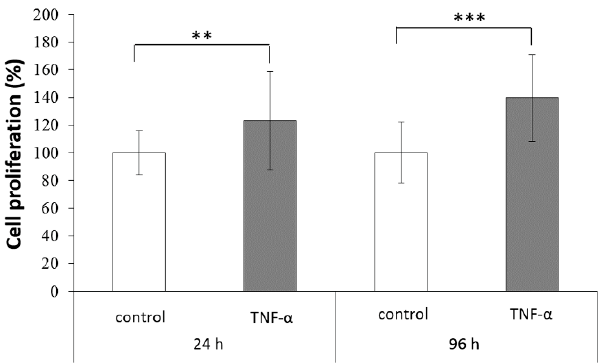
Figure 2. Proliferation of ADSCs treated with tumor necrosis factor (TNF)- α for 24 or 96 h (** p < *** p <